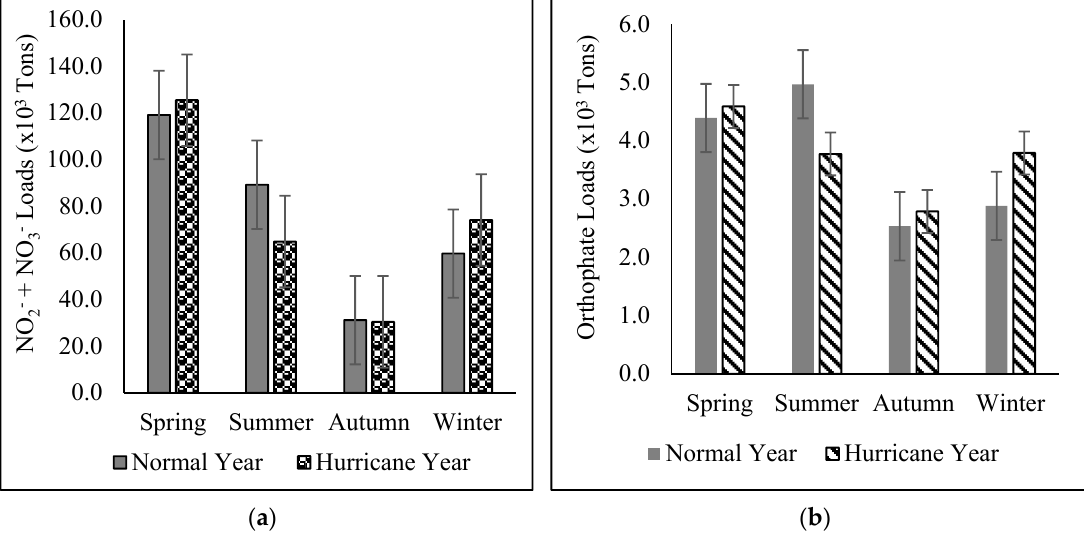
Figure 4. Comparison of seasonal variations of ( a ) NO 2 − + NO 3 − and ( b ) orthophosphate under normal weather and hurricane conditions. Note: Normal weather are years without any storm, and hurricane conditions are hurricane occurrence years.